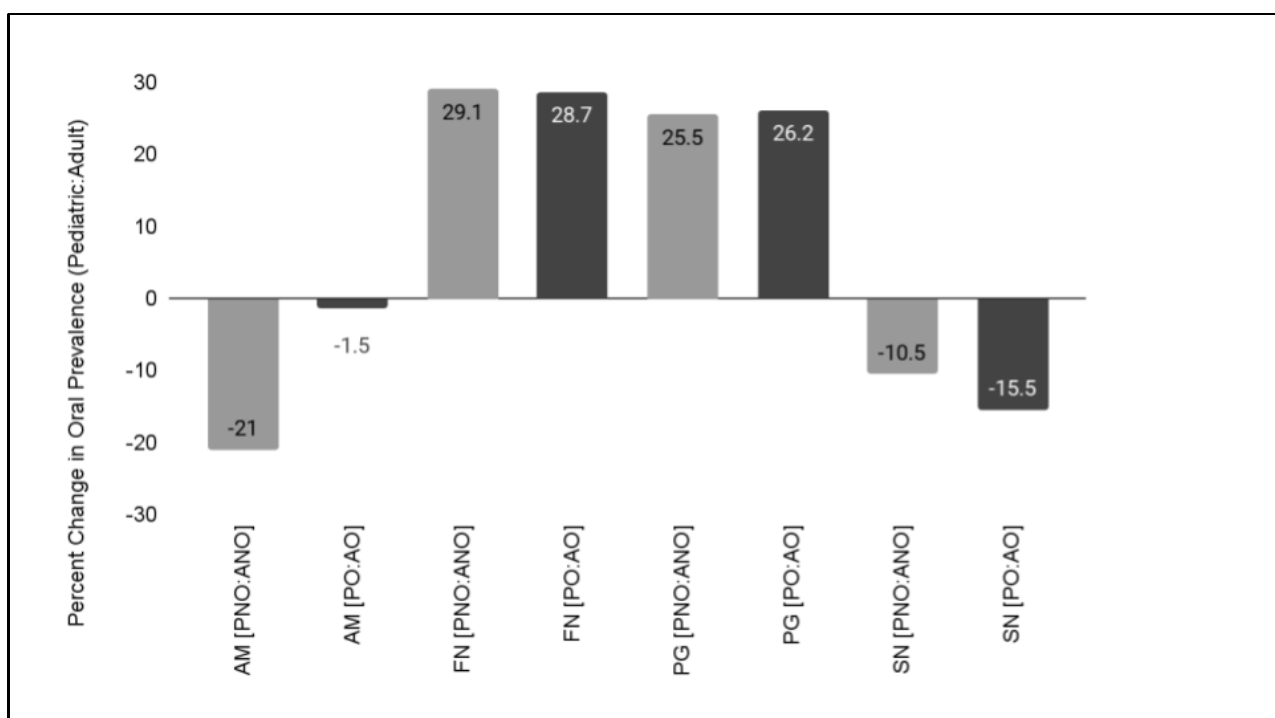
Figure 3. Age-associated difference in oral microbial prevalence. Decreased oral prevalence between pediatric and adult samples was observed for Akkermansia muciniphila (AM) with the largest difference observed between the non-orthodontic samples. In addition, other age-related changes were observed with Fusobacterium nucleatum (FN), Porphyromonas gingivalis (PG) and Selenomonas noxia (SN), although those differences were more similar in direction (positive or negative) and magnitude between orthodontic and non-orthodontic samples.